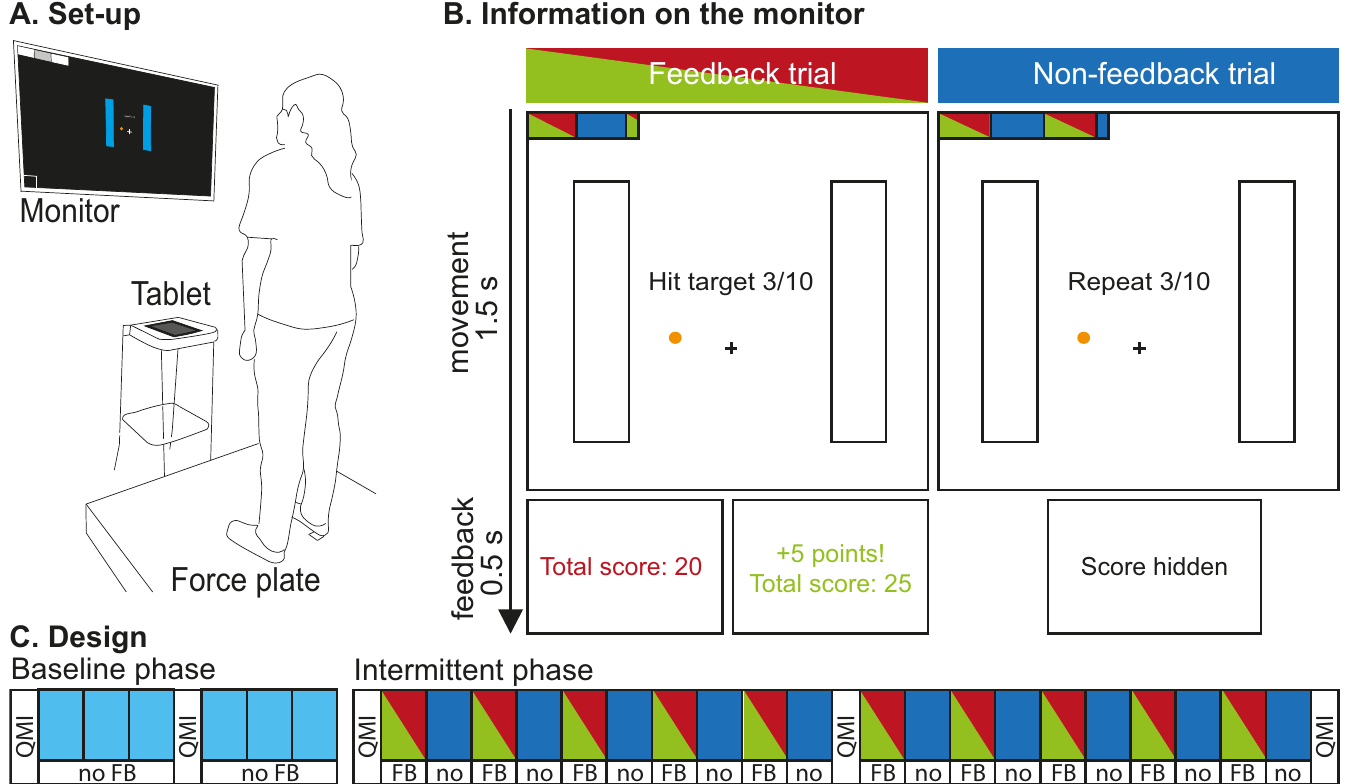
Fig 1. Experimental set-up and design. (A) Overview of the set-up. (B) Information as presented on the monitor. At the onset of and during a trial, the screens displayed a graphical instruction (upper panels). Vertical bars represented the foot position as instructed, the cross represented the center from which to start, and the orange circle represented the target. The horizontal bar in the top left corner represented the progress bar. Instruction strings during the movement depended on trial type. Stochastic binary score feedback was provided following feedback trials, and “Score hidden” was displayed following non-feedback trials (lower panels). (C) Design. A baseline phase was followed by an intermittent phase. Each block contained 10 trials, except for the last block which contained 11 trials. Green-and-red blocks indicate feedback trials; blue blocks indicate non-feedback trials. White bars indicate motivation